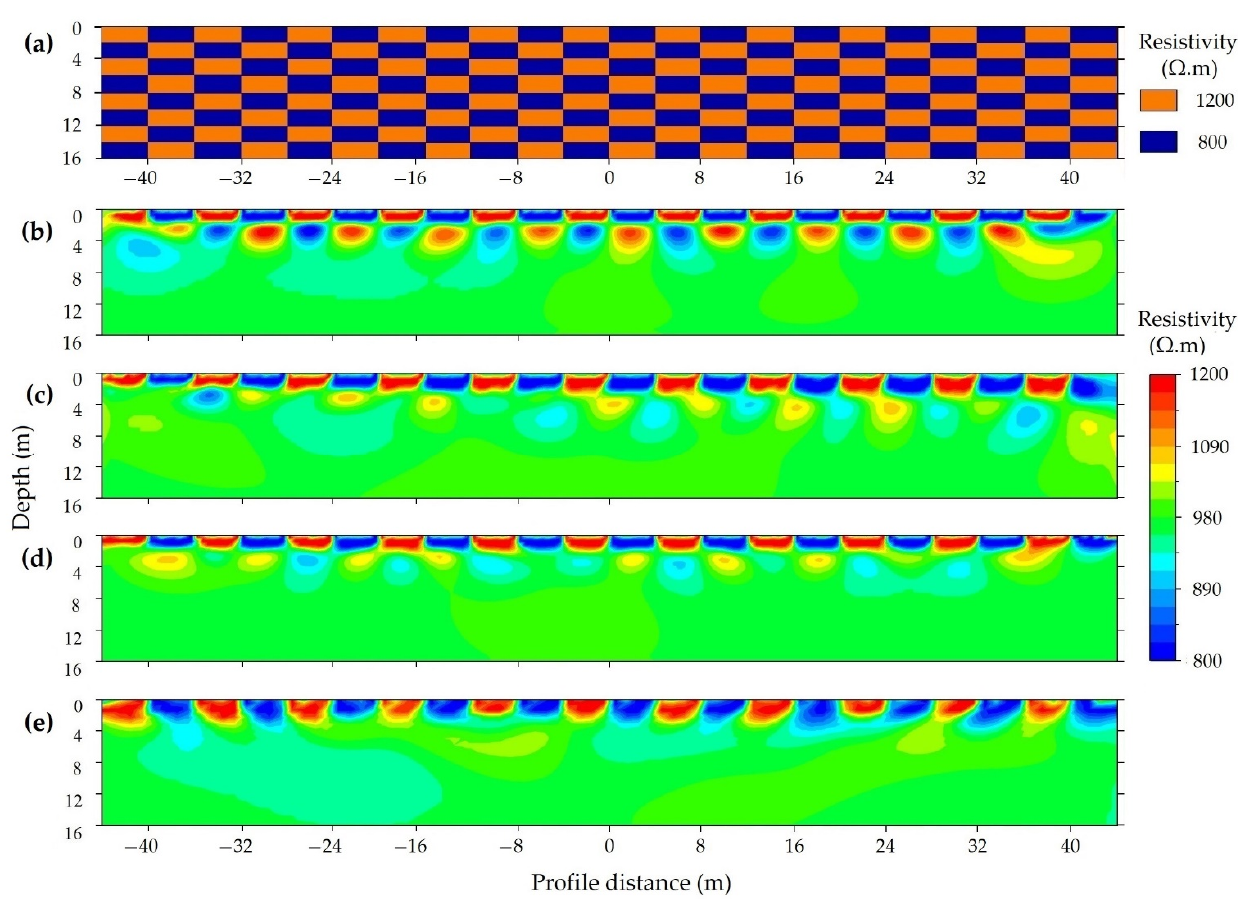
Figure 24. Scenario 2 spatial resolution test for the 2 m (vertical) × 4 m (horizontal) checkerboard cell sizes. ( a ) Checkerboard model, ( b ) DD array, ( c ) PD array, ( d ) WS array, ( e ) PP array.